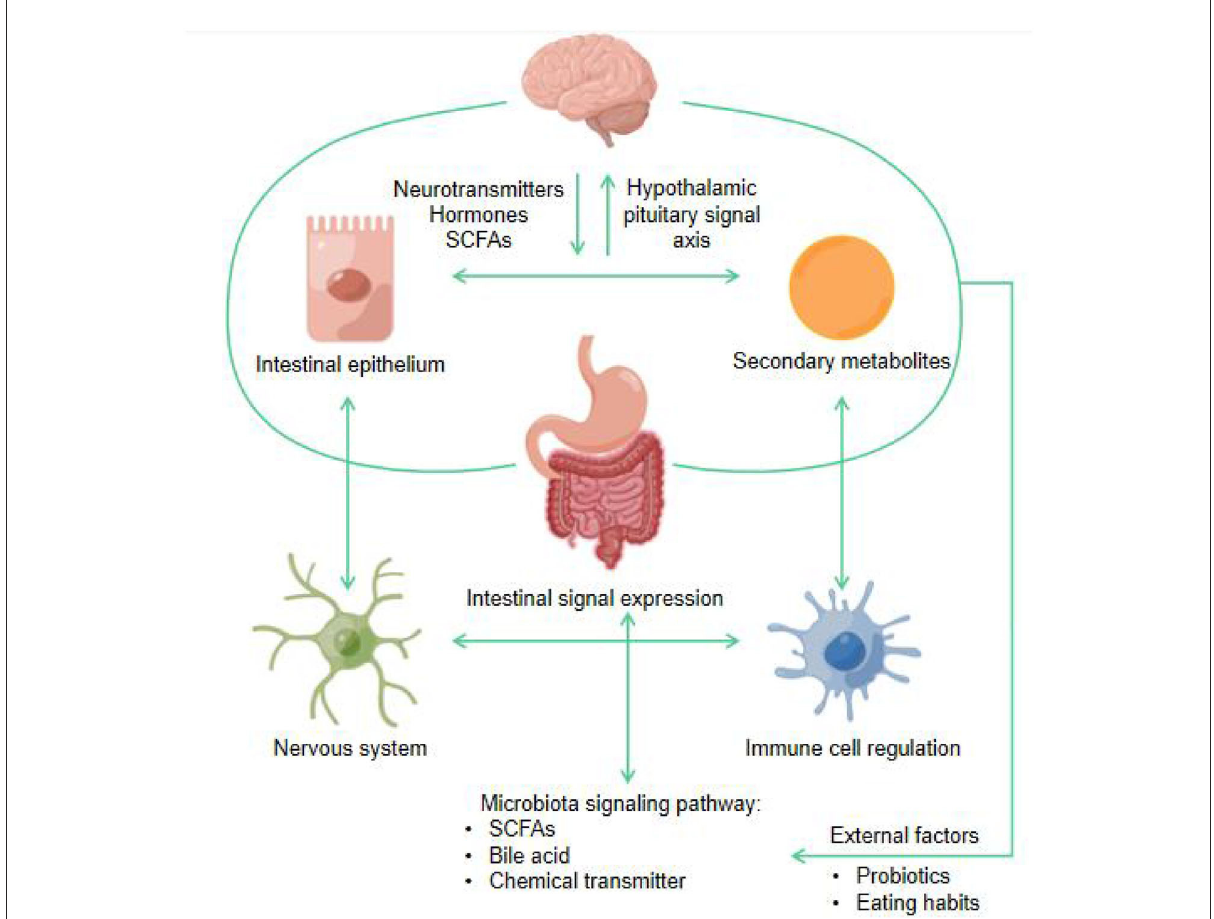
FIGURE8 Schematic diagram of microbiota gut-brain axis bidirectional signal pathway (by Figdraw).